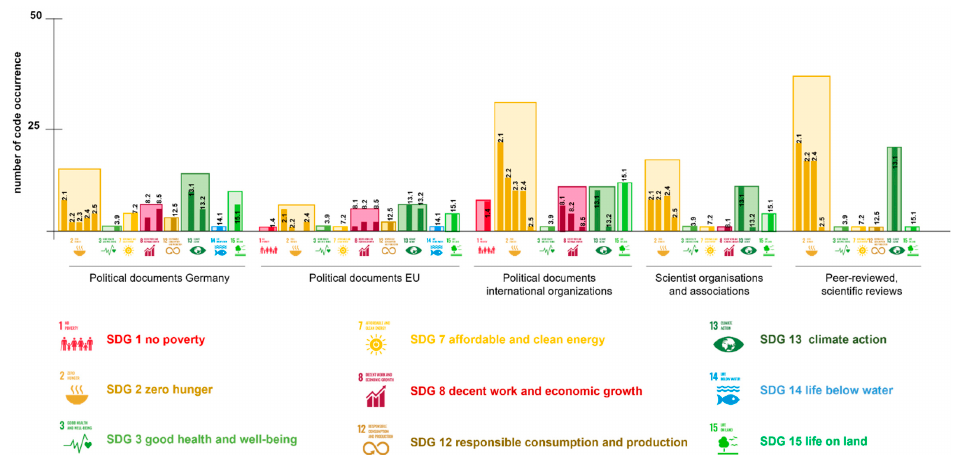
Figure 1. Numbers of expectations coded using SDG per analysed documents. Political documents Germany; political documents EU; political documents international organisations; scientist organ-